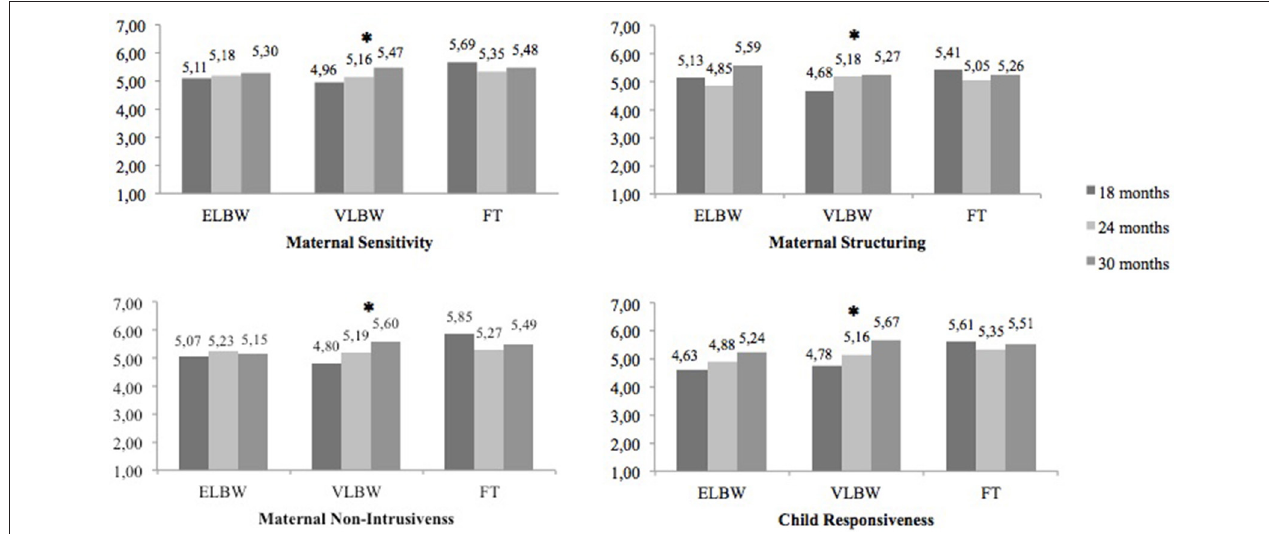
FIGURE 2 | Interaction between birth weight and child age on maternal sensitivity, maternal structuring, maternal non-intrusiveness, and child responsiveness scale. *Stands for significant effects with p <